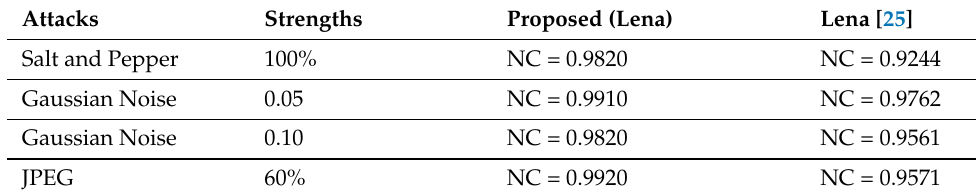
Table 8. Normalized correlation against image processing attacks.